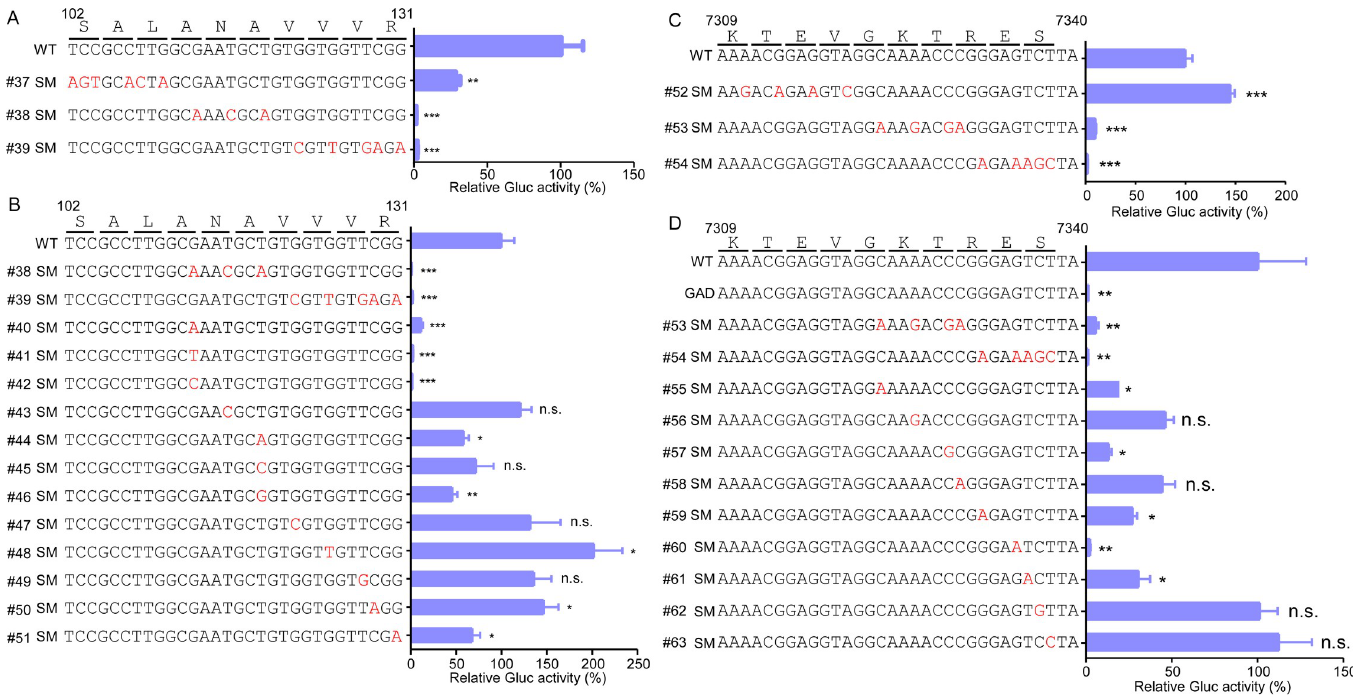
PLOS Pathogens| https://doi.org/10.1371/journal.ppat.1008488 May 20,